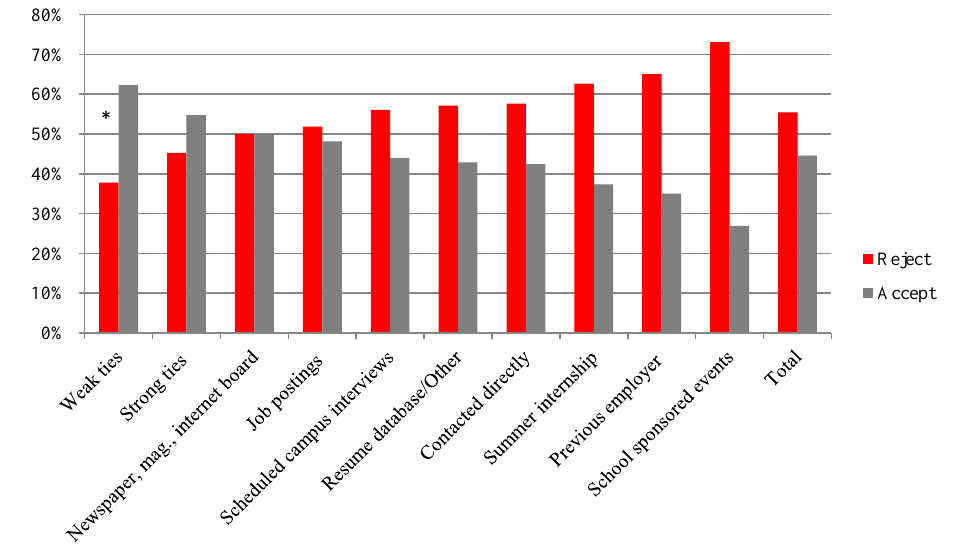
Figure 2: Offer Acceptance/Rejection Rates By Search Channel. Note: Source: Proprietary data from a perennial top US business school. Vertical bars indicate the primary search channel cited for deriving offers that were accepted (grey) or rejected (red). The unit of analysis is the job offer for students with more than one offer (N=478). Bars by choice assessed using LR- χ 2 ( 1 ) . ∗ = p < .05